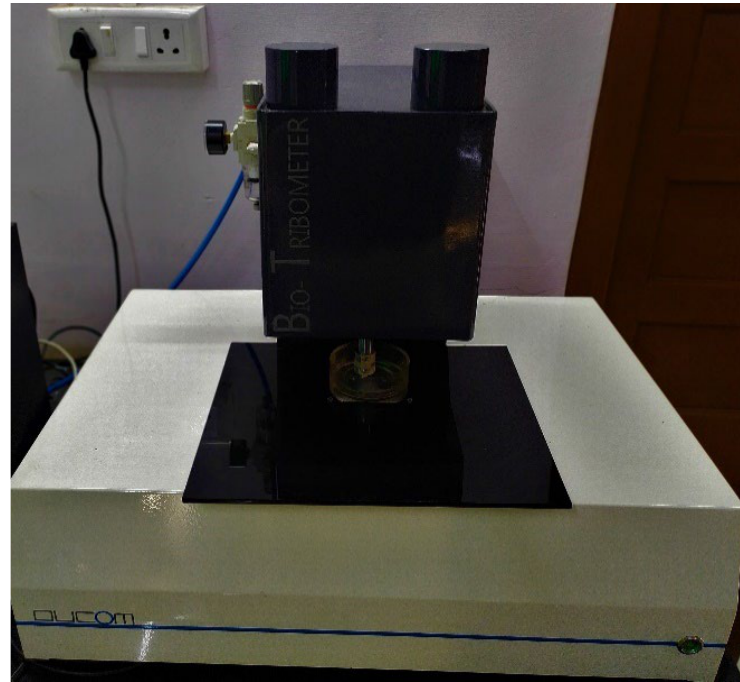
Figure 2. The setup of the Tribometer system.